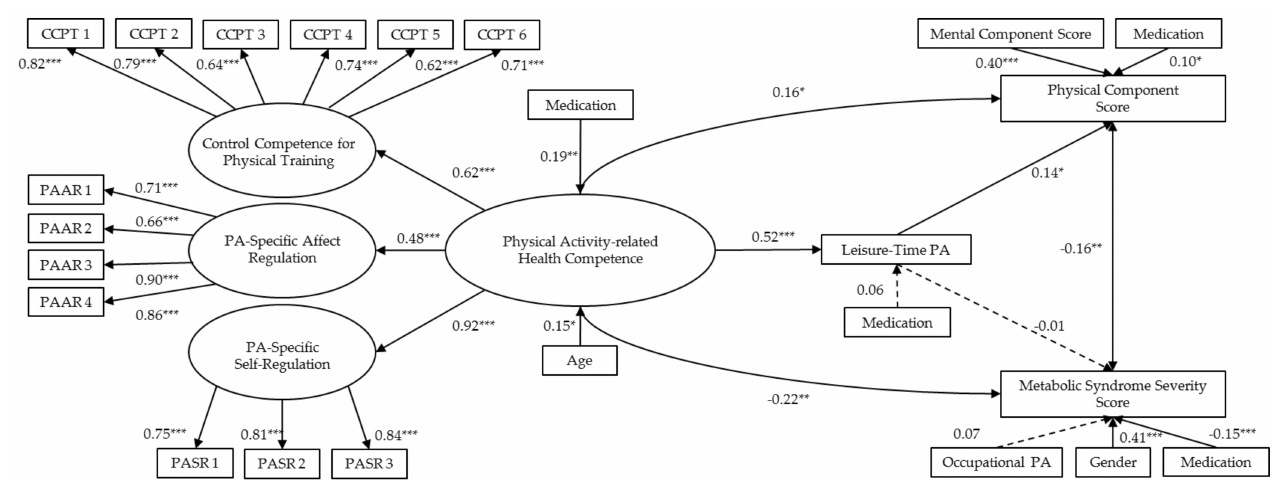
Figure A1. Standardized path coefficients and loadings for the manifest, latent, predictor, mediator, and criterion variables with covariates. Notes. Significant path coefficients are displayed with straight lines and nonsignificant path coefficients are displayed with dashed lines. * p < 0.05, ** p < 0.01, *** p < 0.001 (two sided); Medication = reference group for medication is participants using medication; Gender = reference group is